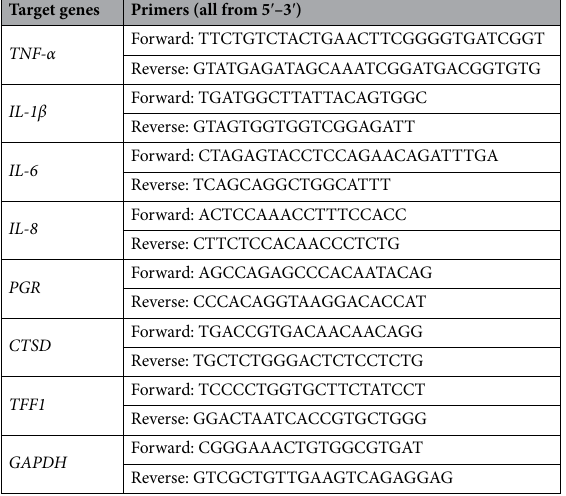
Table1. Primers of target